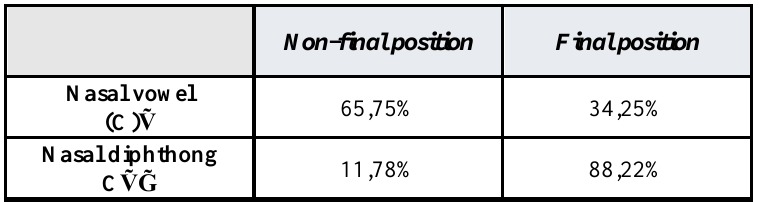
Table 2. Relative frequency of nasal nuclei in standard EP according to the position in the word